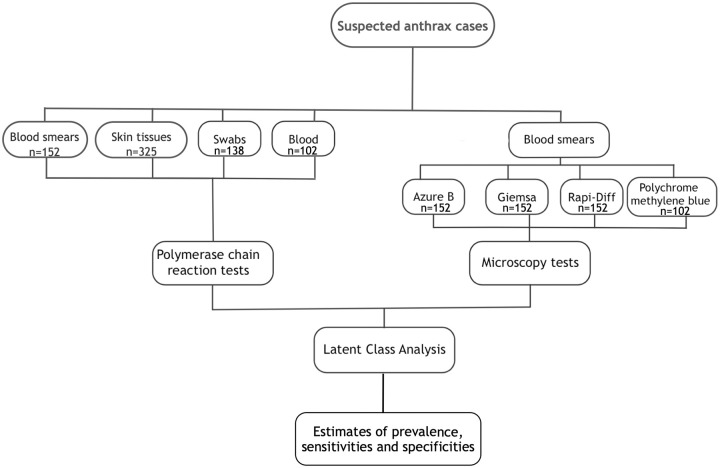
Workflow for samples and data informing the latent class model used to estimate the sensitivities and specificities of different tests used in the diagnosis of suspected anthrax carcasses.